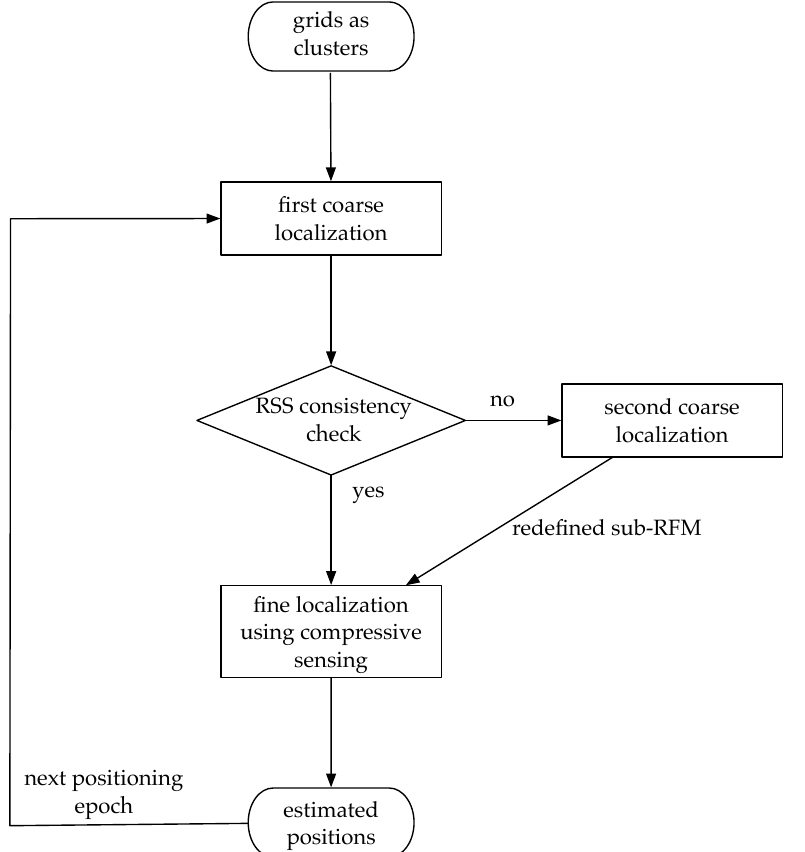
Figure 2. The overall processing structure of the proposed hierarchical